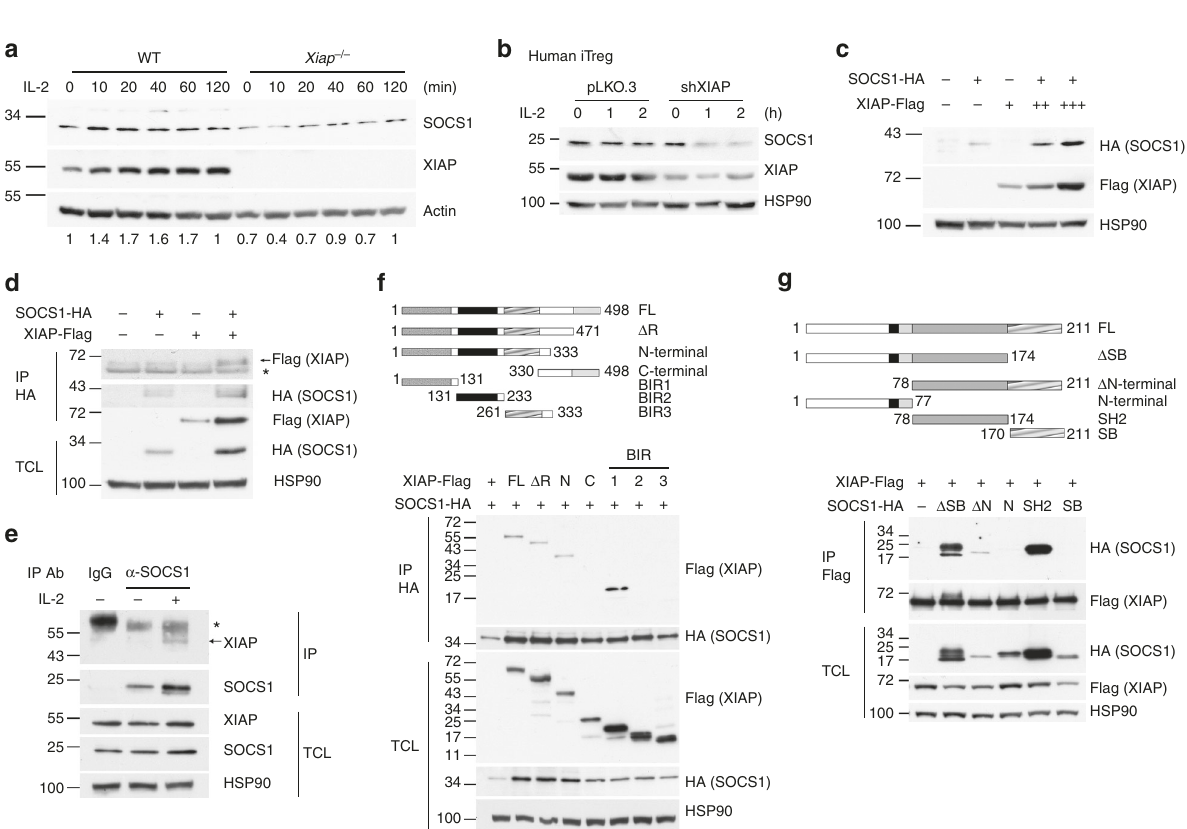
Fig. 3 XIAP interacts with SOCS1 and enhances SOCS1 expression. a XIAP de fi ciency impairs IL-2-induced SOCS1 expression. T cells were collected at 0, 10, 20, 40, 60, and 120 min after IL-2 treatment. SOCS1 expression of lysate was detected by anti-SOCS1. Protein levels were quantitated by densitometry and normalized by actin control. The level of SOCS1 in WT T cells was used as 1 for comparison. b XIAP-de fi ciency decreases SOCS1 expression in human iTreg cells. Control and XIAP-knockdown human iTreg cells were treated with IL-2 and the levels of SOCS1 were determined at the indicated time-points. c XIAP enhances SOCS1 expression. XIAP-FLAG and SOCS1-HA were co-transfected into HEK293T cells. After 24 h of transfection, cell lysates were prepared and SOCS1 and XIAP expression was determined with anti-FLAG and anti-HA. d XIAP interacts with SOCS1. XIAP-FLAG and SOCS1-HA were co- transfected into HEK293T cells as indicated. Total cell lysates were immunoprecipitated by anti-HA and the presence of SOCS1 and XIAP-FLAG in the precipitates and lysates was determined. * indicates immunoglobulin heavy chain. e Endogenous XIAP interacts with SOCS1. Mouse peripheral T cells from spleen and lymph nodes were treated with IL-2 as indicated and then 600 μ g of cell lysates were immunoprecipitated with anti-SOCS1 or control goat IgG. The contents of endogenous XIAP were determined. * indicates immunoglobulin heavy chain. f The BIR1 domain of XIAP interacts with SOCS1. Full-length (FL), RING domain-deleted ( Δ R), N-terminus (N), C-terminus (C), BIR1, BIR2 or BIR3 of XIAP-FLAG were co-transfected with SOCS1-HA into HEK293T cells. Total cell lysates were immunoprecipitated with anti-HA and the presence of XIAP variants and SOCS1 in the pull-down complex and cell lysates was determined. g The SH2 domain of SOCS1 binds XIAP. Full-length (FL), SOSC box-deleted ( Δ SB), N-terminal-deleted ( Δ N), N-terminal (N), SH2 domain, or SOCS box (SB) of SOCS1 were transfected with XIAP-FLAG into HEK293T cells as indicated. Total cell lysates were immunoprecipitated by anti-FLAG and the presence of SOCS1 variants and XIAP in the precipitates and cell lysates was determined. Each experiment ( a , c – g ) was independently repeated three times with similar